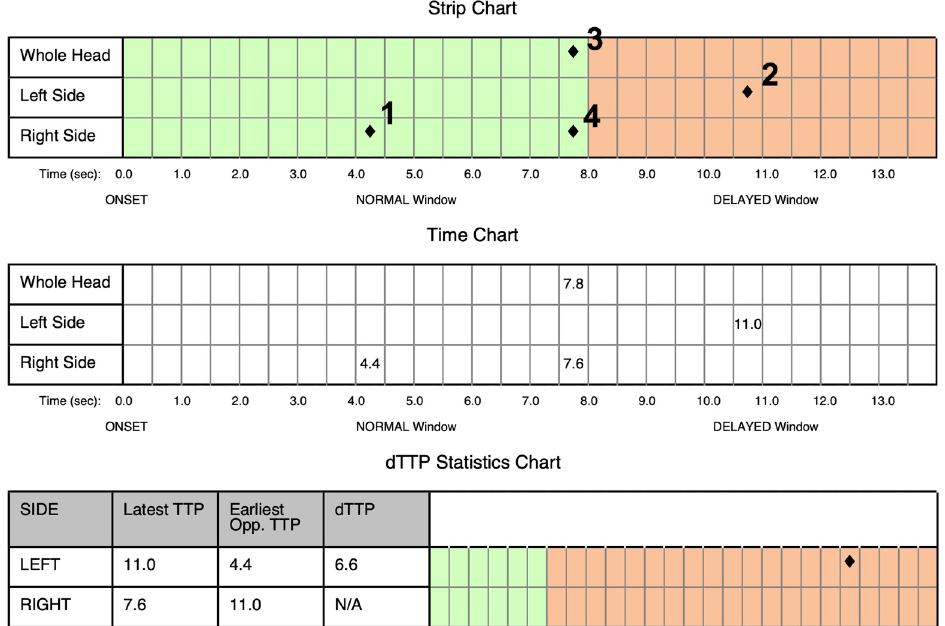
Figure 4. Analysis of time intensity curves representing brain perfusion ultrasound using SONAS ® . Upper row: 1—first time-to-peak (TTP) in the “healthy” right hemisphere, 2—delayed left hemi- spheric peak, 3—peak of the whole brain, and 4—delayed second peak probably representing right anterior cerebral artery crossflow as the primary collateral pathway. Middle row: absolute time values of the peaks. Lower row: expression of the difference in time-to-peak values (delta-TTP) expressing the absolute perfusion deficit in the left hemisphere.